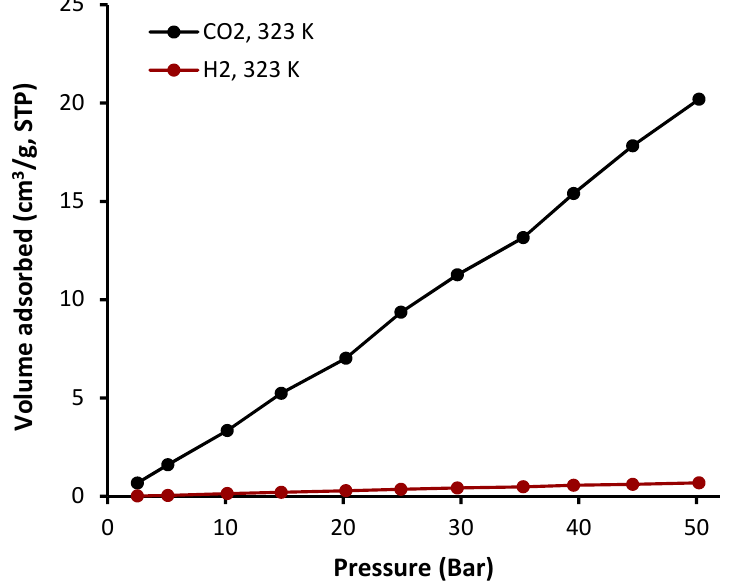
Figure 9. Adsorption isotherms of CO 2 and H 2 for complex 2 .